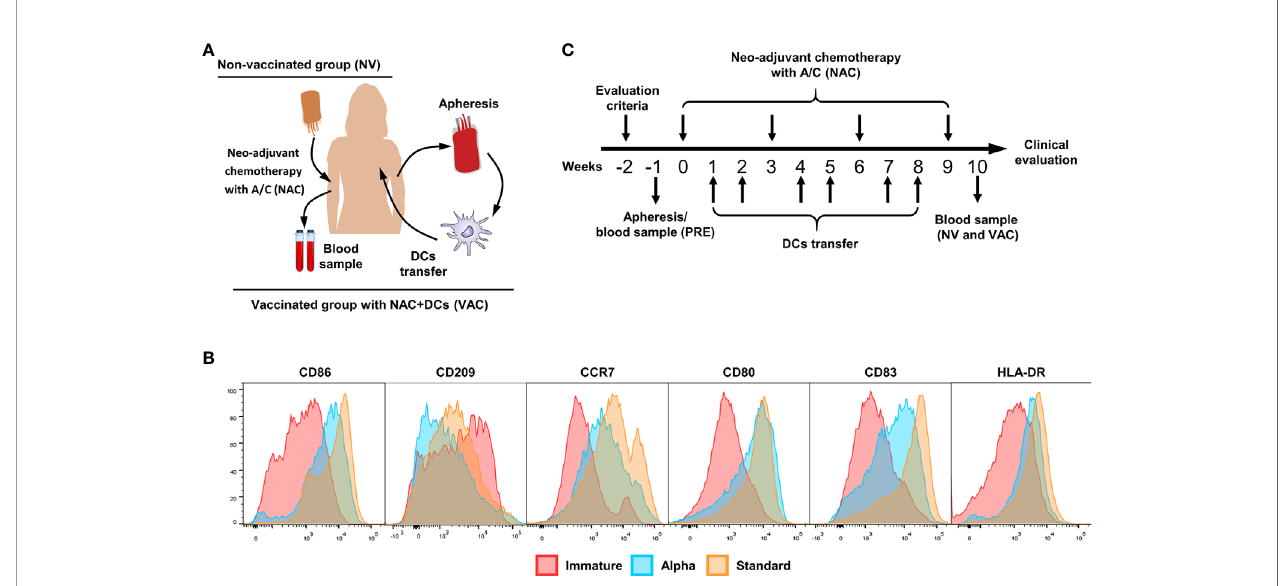
FIGURE 1 | Vaccination scheme and dendritic cell (DC) characterization. (A) Patient interventions, before NAC, patients have gone to an apheresis collection to obtain peripheral blood mononuclear cells (PBMCs) and therefore induce monocyte-derived DCs (cryopreserved until use). After four doses of chemotherapy, a new blood sample was taken to compare between pre- and post-chemotherapy. (B) Representative histograms of immature DCs (red), alpha DCs (blue), and standard DCs (yellow), comparing the expression levels of CD86, CD209, CCR7, CD80, CD83, and HLA-DR. (C) Clinical trial scheme per patient in weeks, week 0 is referred to the fi rst dose of chemotherapy, the process starts with the evaluation criteria for patients (w-2), apheresis (vaccinated group) or blood sample (control group) was taken in w-1. Between doses of chemotherapy, we transferred two doses of DCs for a total of six doses. One week after the fourth dose of A/C, we collect the second blood